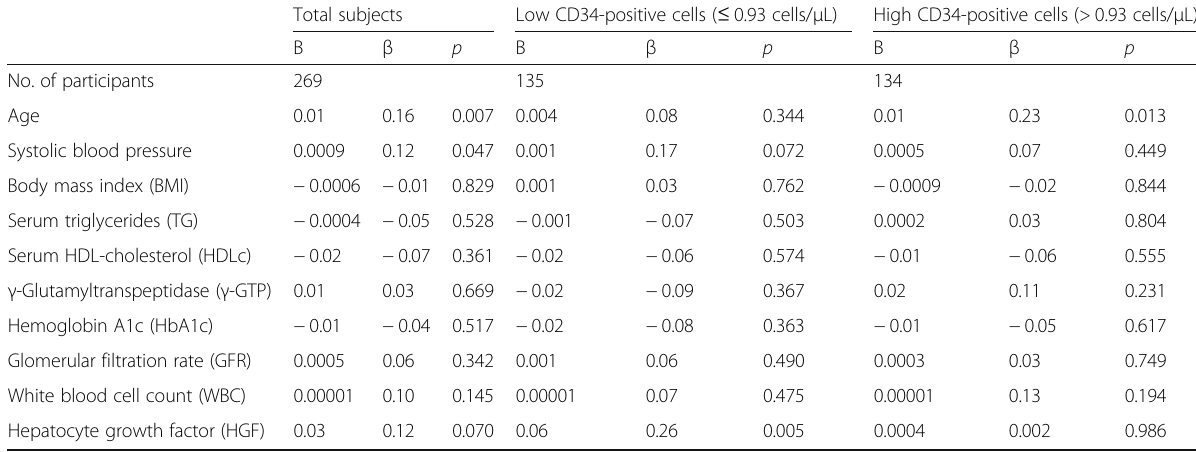
Table 3 Multiple linear regression analysis of carotid intima-media thickness (CIMT)